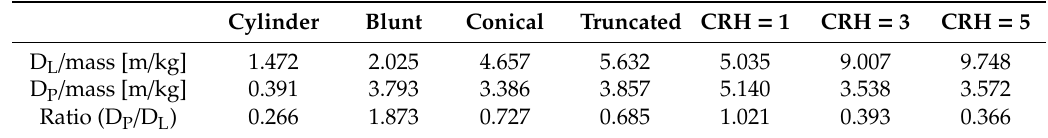
Table 2. Penetration depth concerning the projectile geometry in the oblique